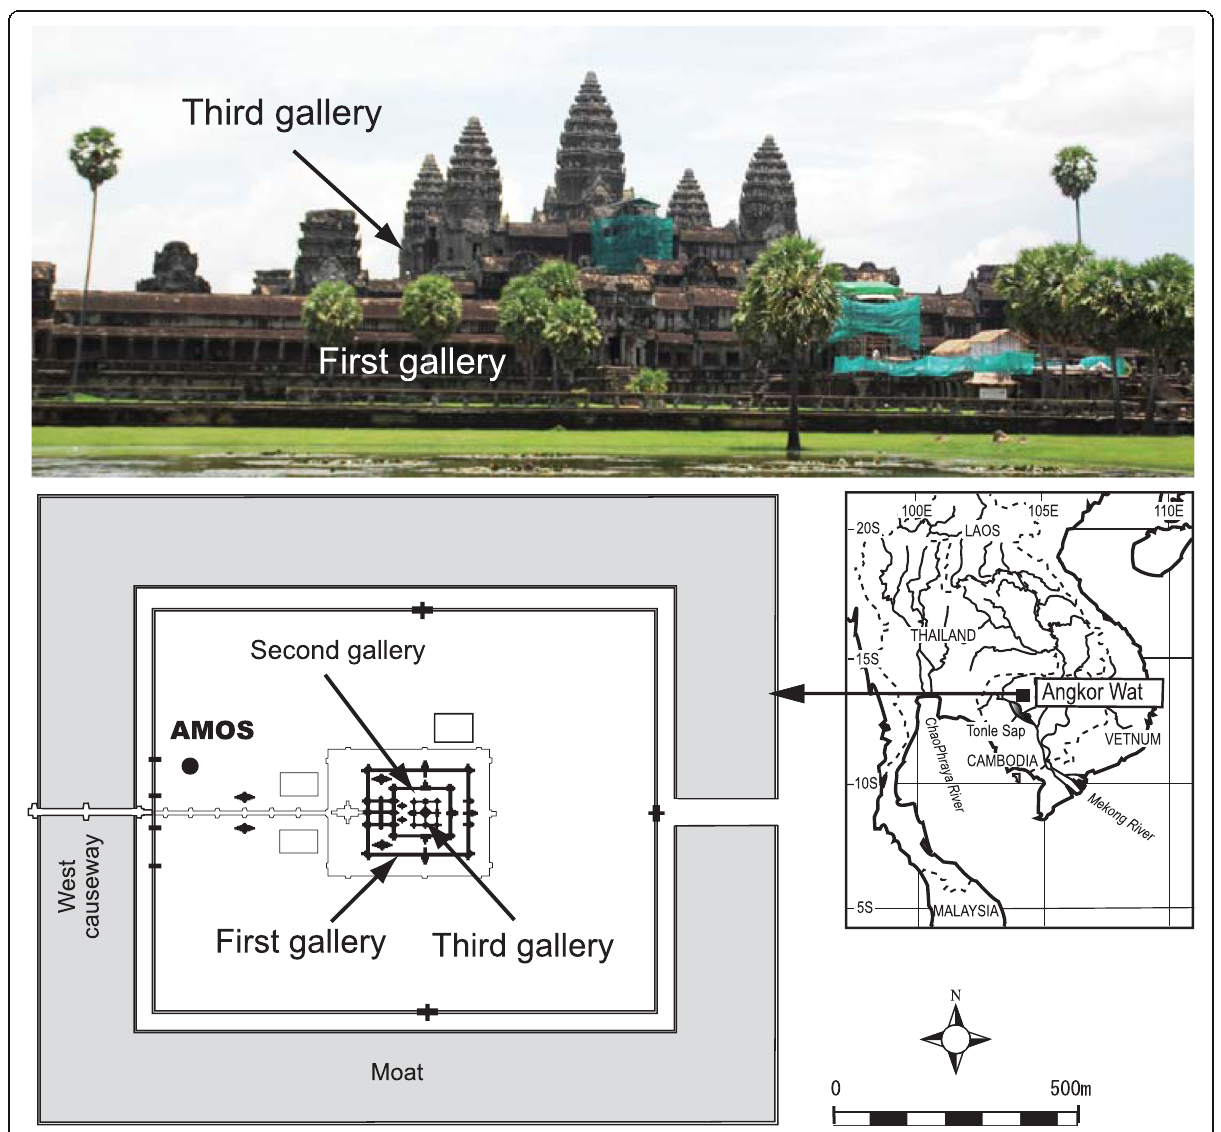
Fig. 1 Location of Angkor Wat temple and the study site. AMOS; Meteorological observation station in Angkor Wat